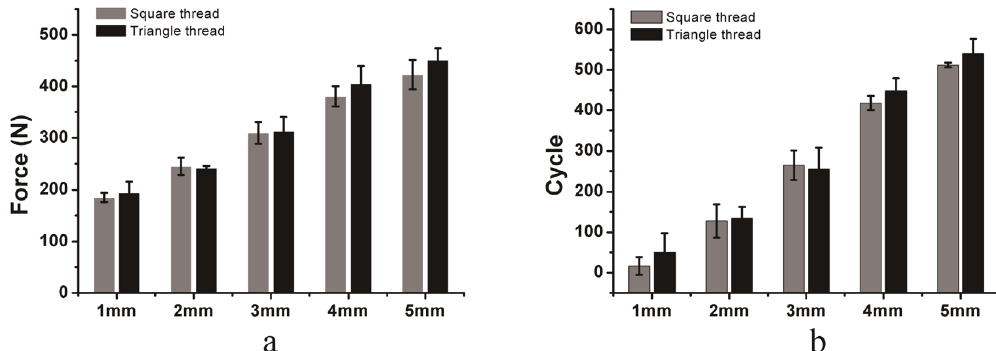
Figure 7. Comparison of the force ( a ) and number of cycles ( b ) required to achieve a 1, 2, 3, 4, and 5 mm displacement of the compression screws (DCP fixation) with square threads and triangle threads under cyclic craniocaudal loading. Mean values ± standard deviation of the measured values are presented (N = 5) (Student’s t-test, *p < 0.05, **p < 0.01).